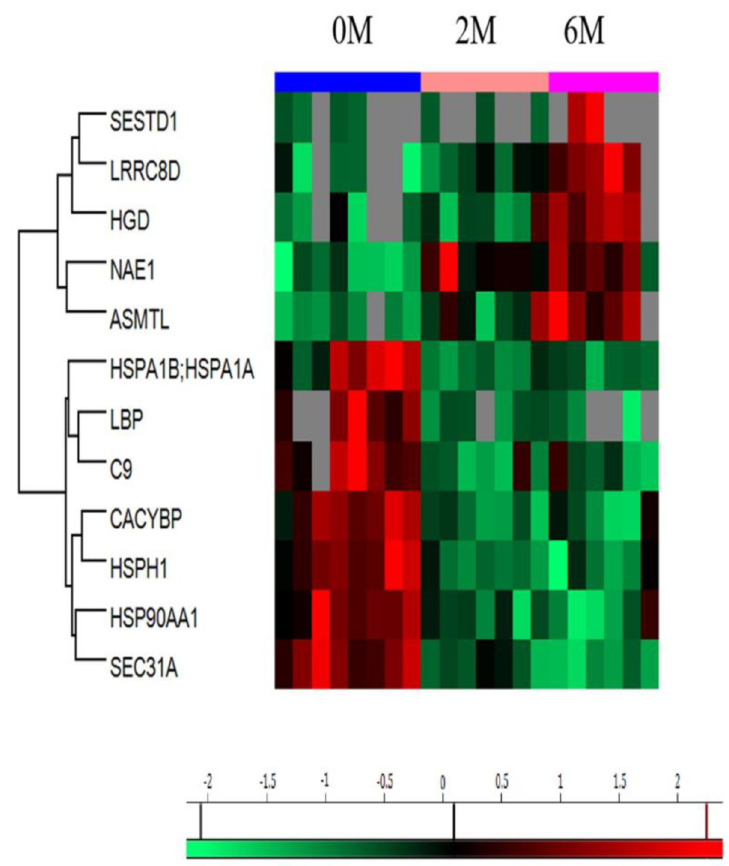
Fig 1. Heat map illustrating hierarchical clusters of the 12 differentially expressed proteins among the pulmonary tuberculosis patients’ PMNCs samples at baseline "0M" (n = 8), 2 months "2M" (n = 7), and 6 months "6M" (n = 6). Each row represents a single protein. The columns depict the expression levels of individual samples. The color intensity of each panel is proportional to the relative intensities of the proteins; higher intensities are associated with red and lower intensities with